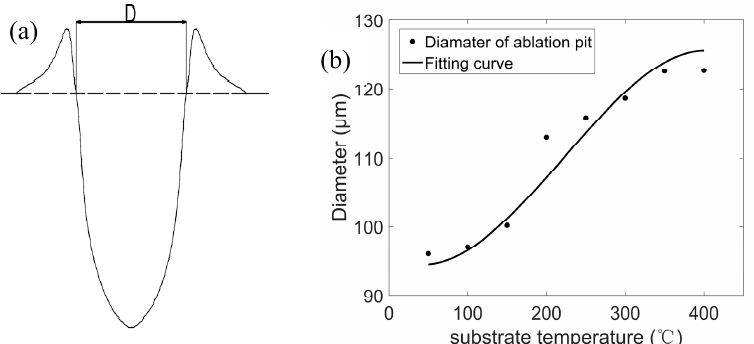
Figure 5. ( a ). How we measured diameter of ablation craters; ( b ) diameter of ablation craters under Figure 5. (a). How we measured diameter of ablation craters; (b) diameter of ablation craters under di ff erent substrate different substrate temperature.